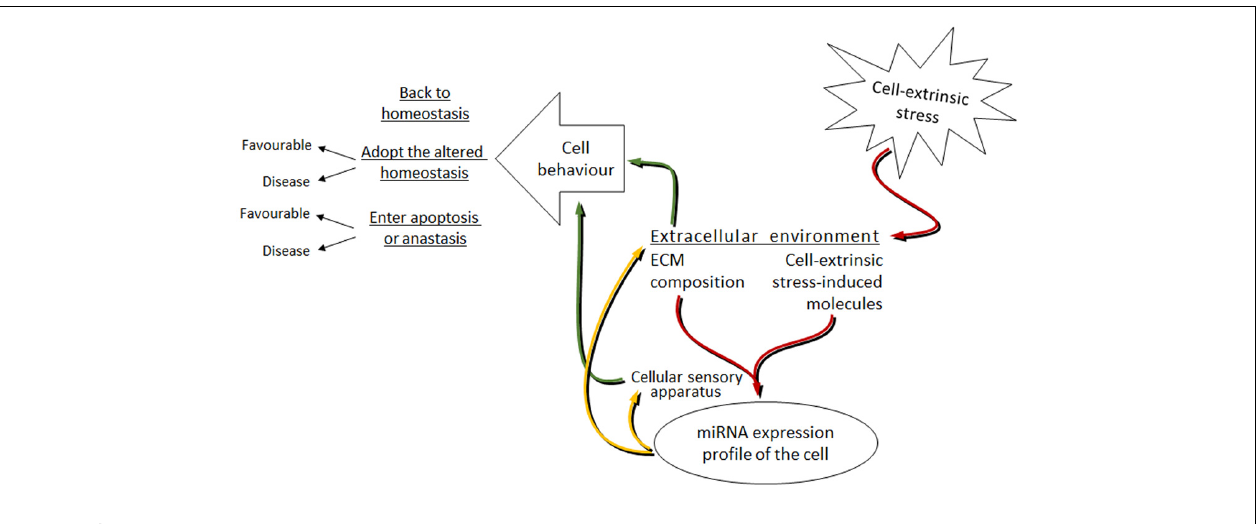
sensory apparatus to change the miRNA expression profile of cells. Yellow arrows: altered miRNA levels target the cellular sensory apparatus and the extracellular environment. Green arrows: this leads to the changes in cell behavior. The mode of cell behavior is different dependent on the strength and length of the applied cell-extrinsic